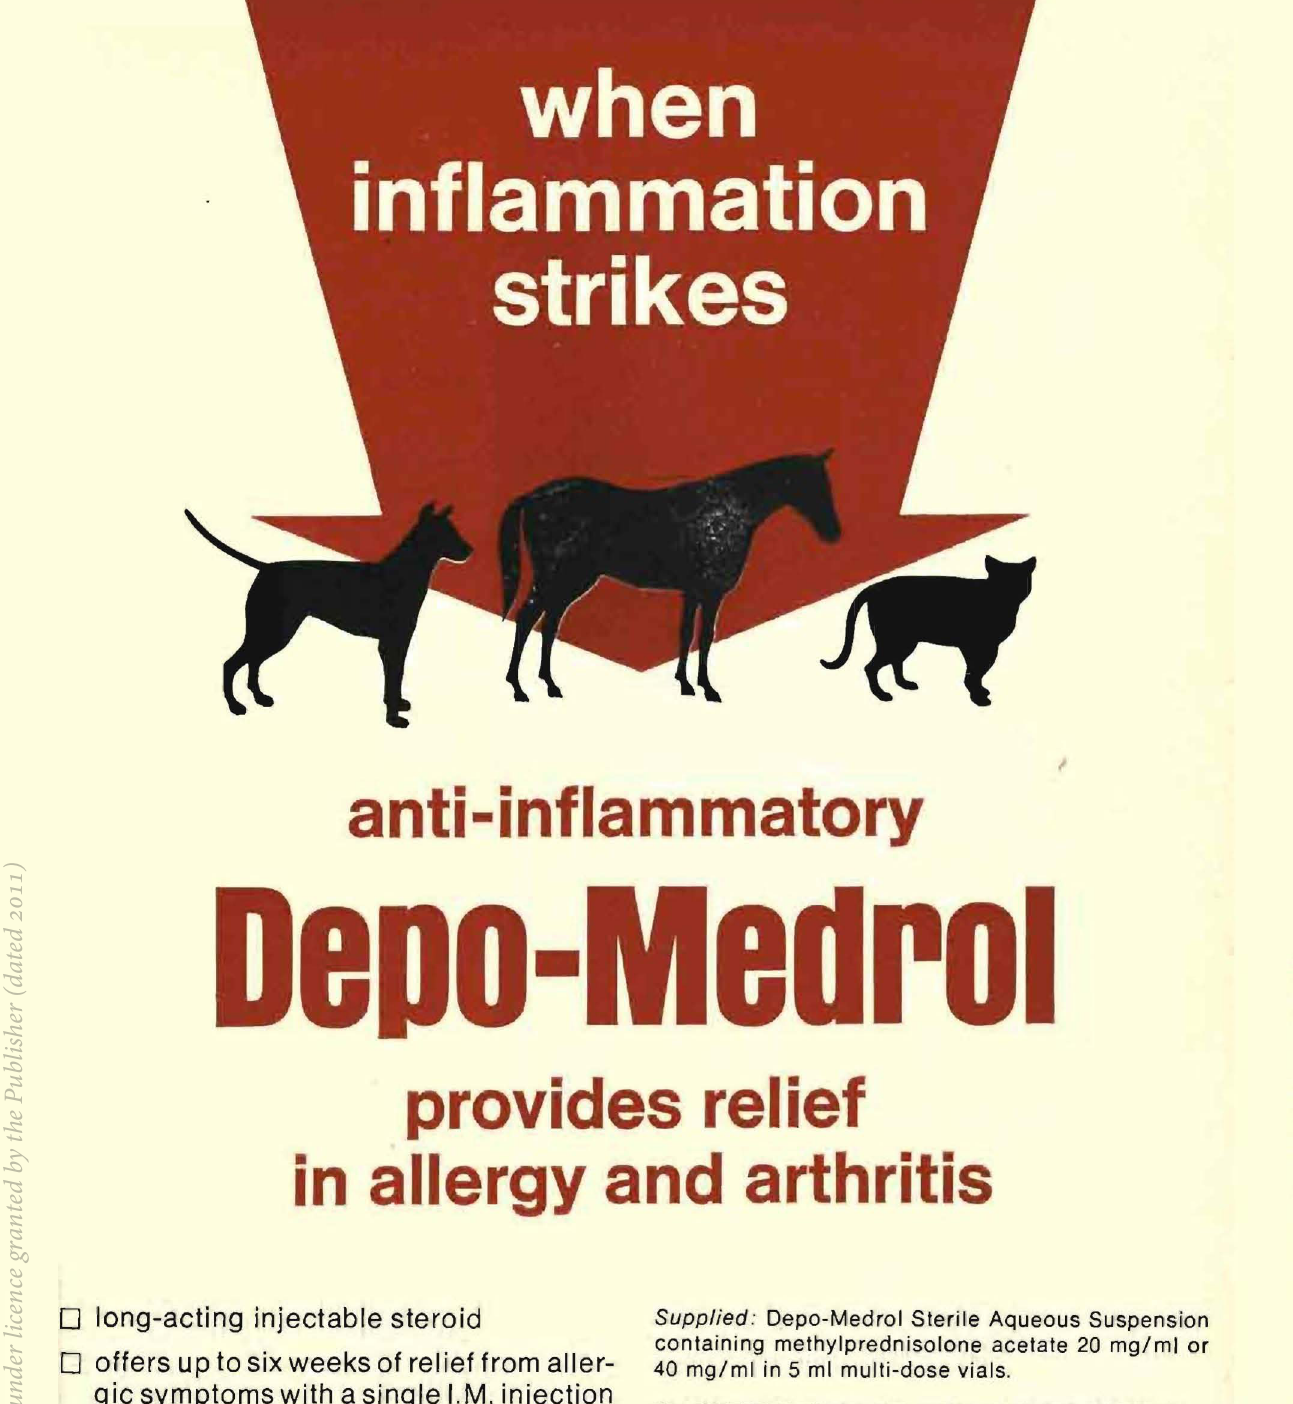
Supplied: Depo-Medrol Sterile Aqueous Suspension containing methylprednisolone acetate 20 mg/ml or 40 mg/ml in 5 ml multi-dose